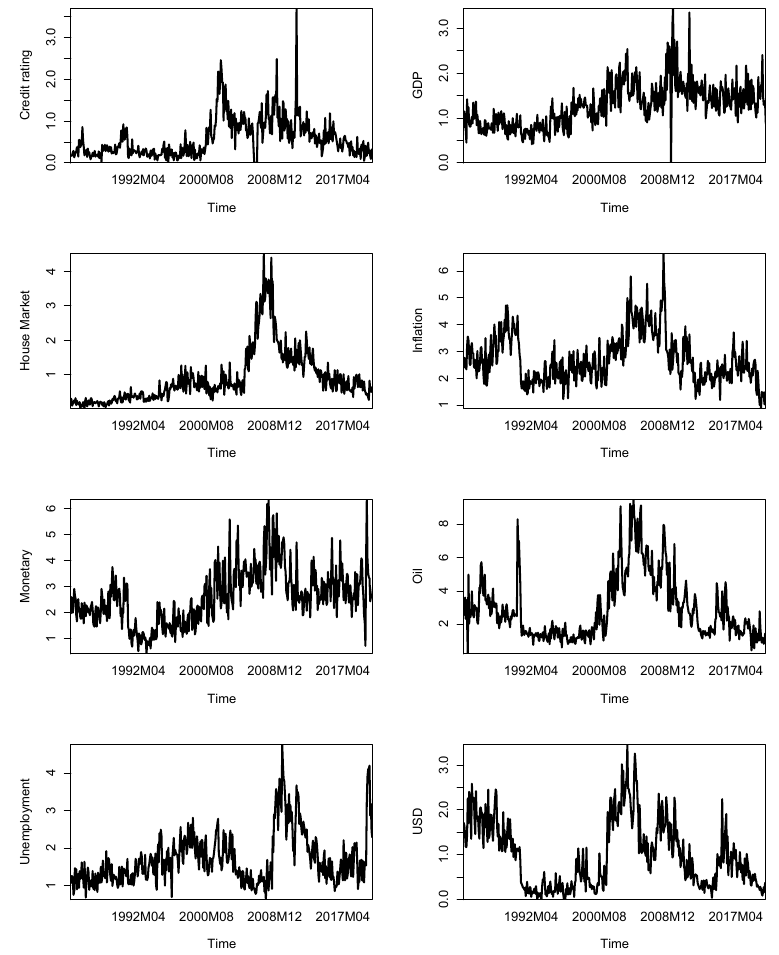
Figure A2. Wall Street Journal fundamentals.